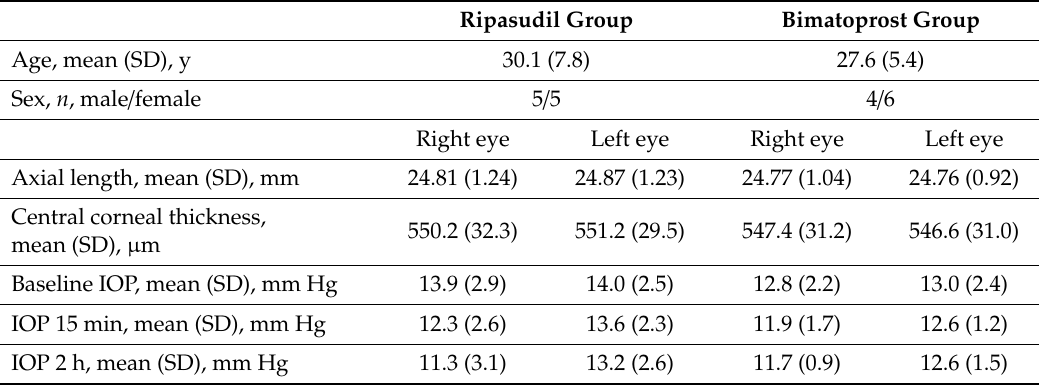
Table 1. Baseline characteristics of participants and course of intraocular pressure. Ripasudil Group Bimatoprost Group 30.1